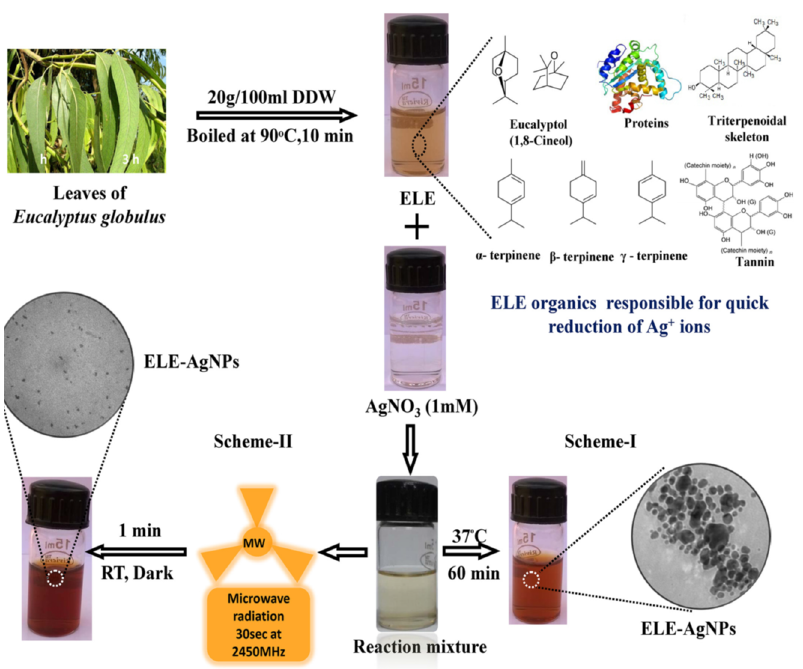
Figure 5. Graphical representation of AgNPs synthesis with Eucalyptus globulus leaf extract (ELE) and silver nitrate depicting scheme-I (without microwave treatment) and scheme-II with microwave irradiation. Reproduced from [106] with permission of Public Library of Science.